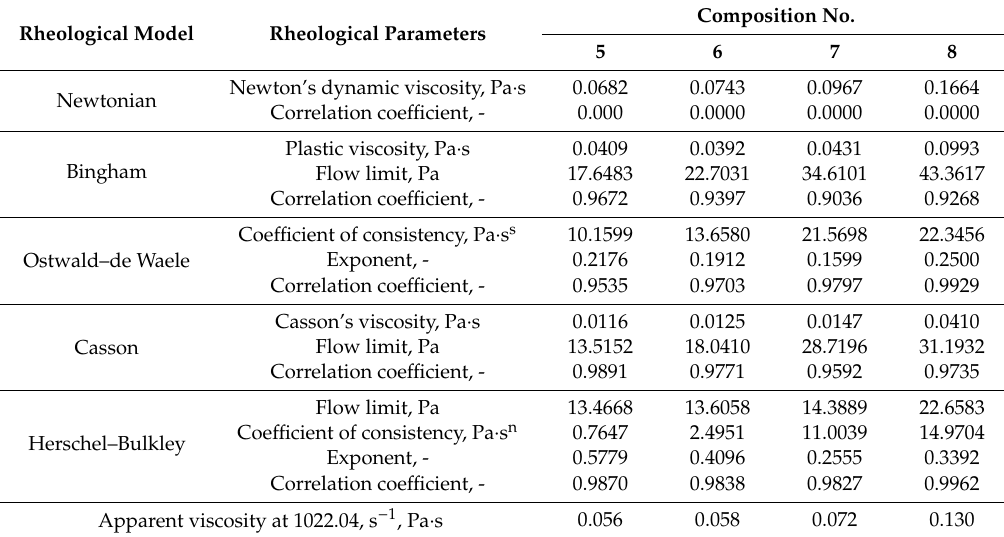
Table 3. Parameters of selected rheological models for slurries prepared with graphene oxide containing a latex admixture.